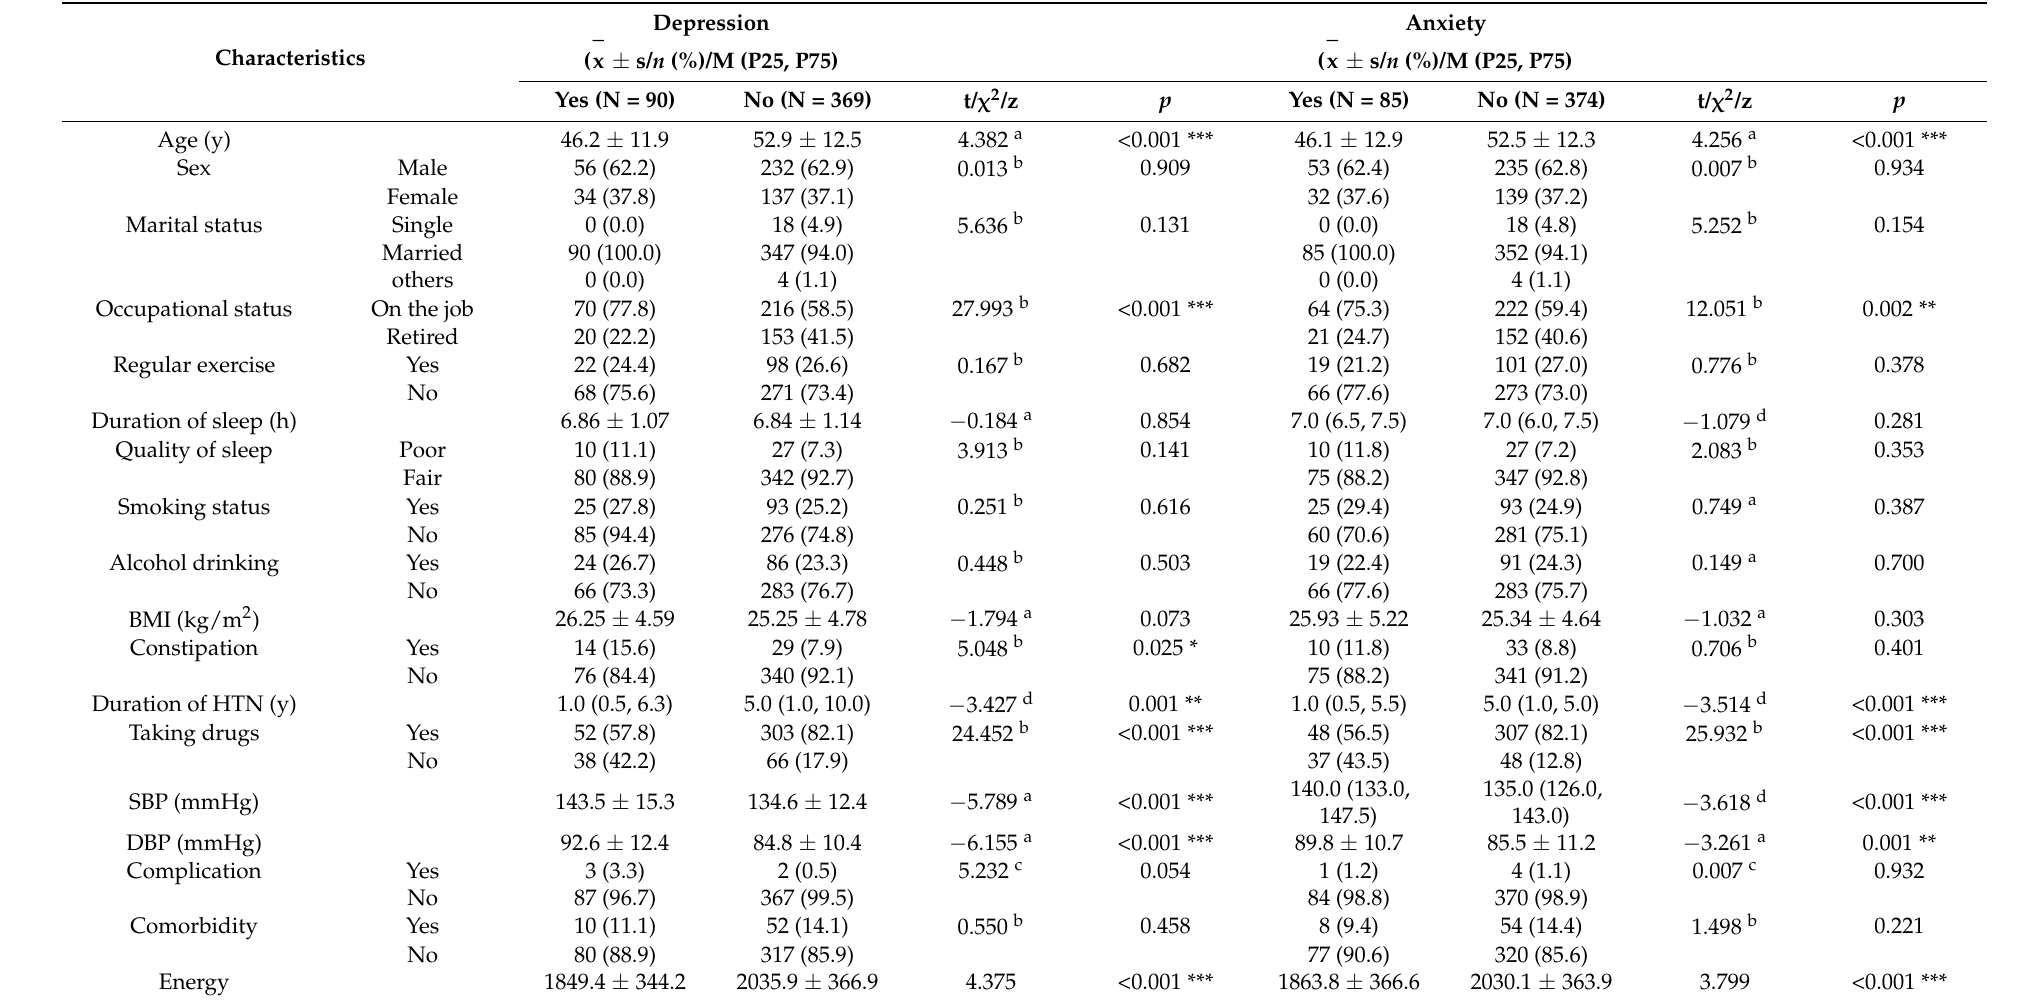
Table 1. Socio-demographic and clinical characteristics ( n =